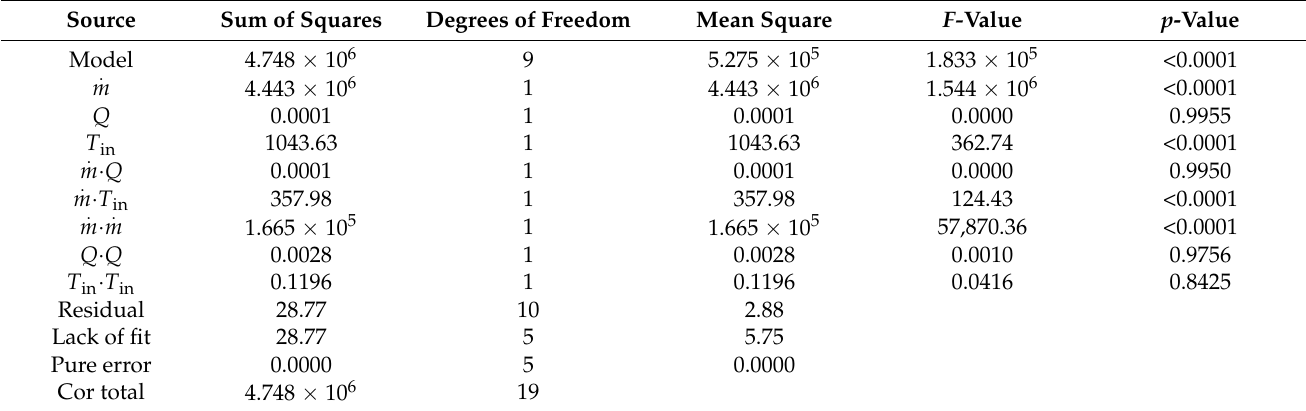
Table 6. The ANOVA for the pressure drop (before